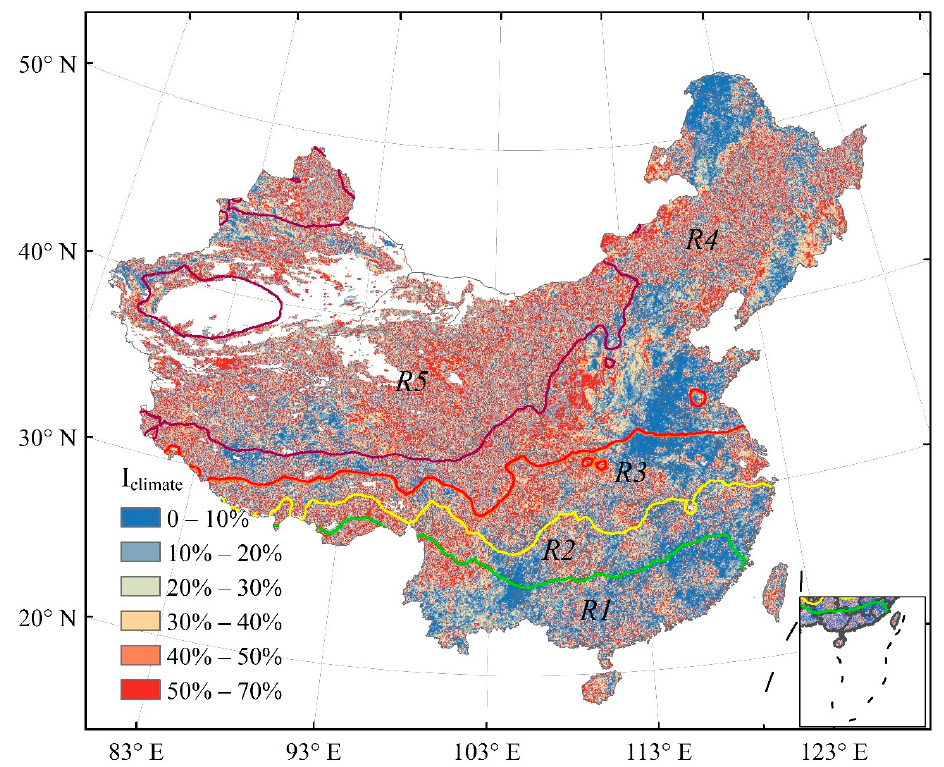
Figure 9. The spatial distribution of the effects ( I climate ) of climate change on vegetation activity in the growing season from 1982 to 2020. The colored lines from south to north refer to the contour lines of OMR values of 650, 700, 750 and 800 kg/ kg, respectively. The author used the software of ArcGIS 10.5 to produce the figure. Table 4. Impacts of climate change ( I climate ) on terrestrial vegetation growth in China. The unit is %.